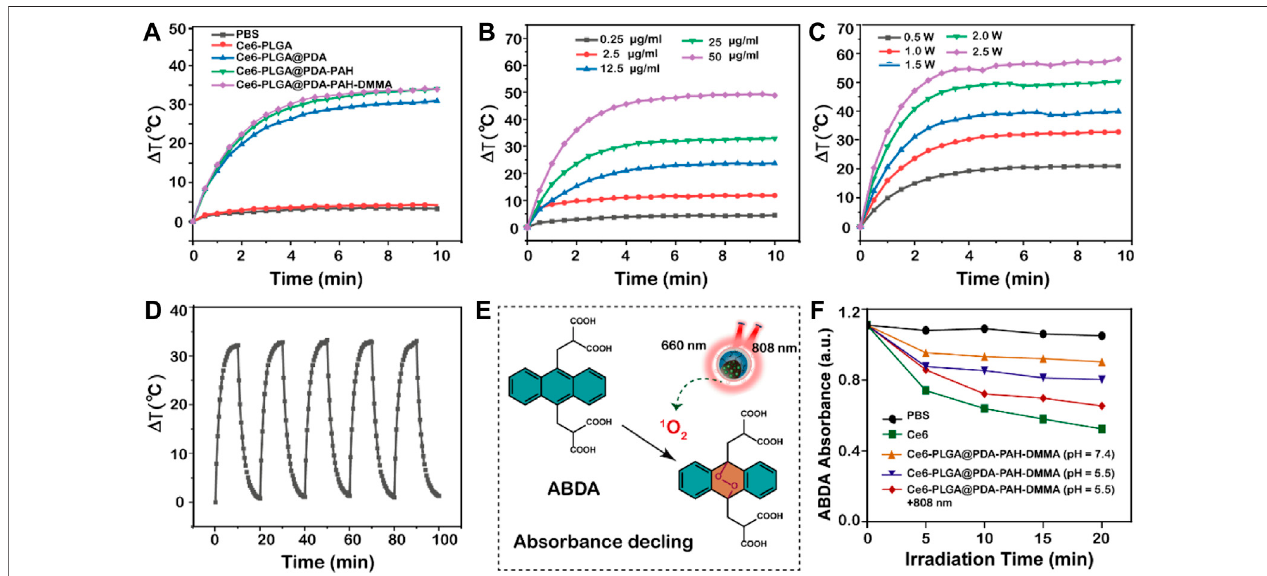
FIGURE 3 | Photothermal properties. (A) Heating curves of different NPs after irradiating by the 808-nm laser. (B) Photothermal heating curves of different concentrations of Ce6-PLGA@PDA-PAH-DMMA NPs irradiated by the 808-nm laser (1.5 W/cm 2 , 10 min). (C) Temperature changes of Ce6-PLGA@PDA-PAH-DMMA NPs exposed to the 808-nm laser in different power densities. (D) Heating/cooling curves for 10 min-on – 10 min-off laser irradiations (808 nm, 1.5 W/cm 2 , 5 times). (E) Detection mechanism of ABDA for 1 O 2 . (F) Absorption spectra of ABDA for 1 O 2 generation in different formulations treated in different